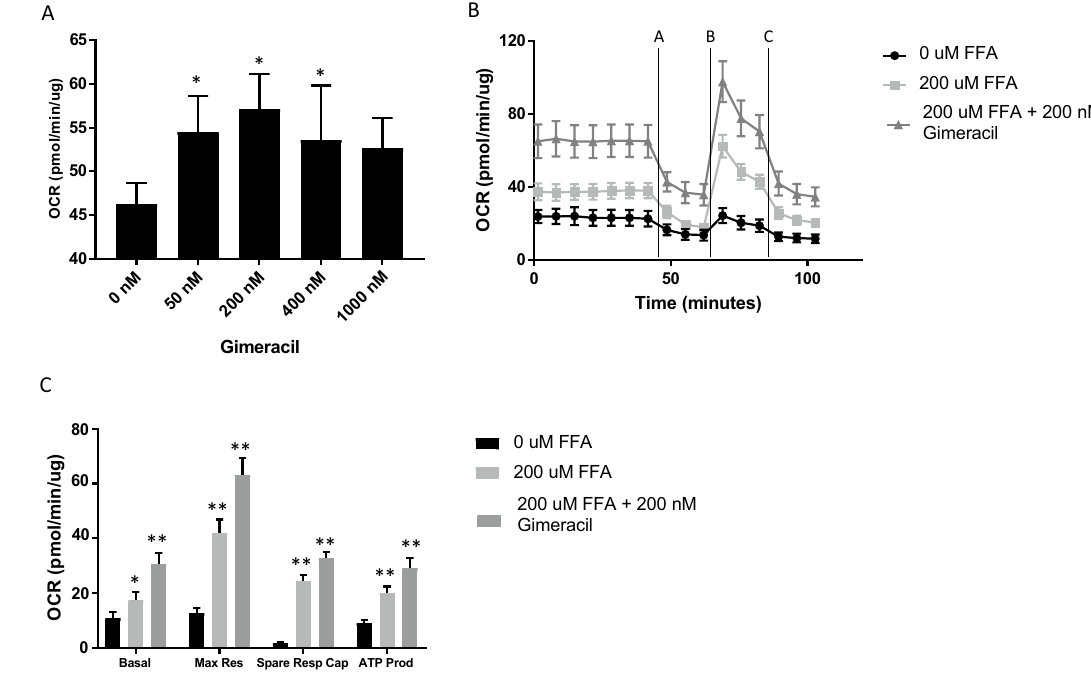
Figure 3. Extracellular flux analysis demonstrates enhanced mitochondrial functionality in PHHs treated with Gimeracil. Mitochondrial stress test involves the addition of oligomycin A (2.0 µM, time interval A) FCCP (2.0 µM, time interval B) and Rotenone Antimycin A (0.5 µM, time interval C). * indicates adjusted p-value < 0.05 and ** indicates adjusted p-value < 0.0001. ( A ) PHHs treated with increasing concentrations of the Gimeracil in the presence of 200 µM palmitic and oleic acid demonstrate a significant increase in oxygen consumption rate (OCR) at 50 nM (adjusted p-value 0.0173), 200 nM (adjusted p-value 0.0017) and 400 nM (adjusted p-value 0.0754). The increased observed at 1000 nM is not statistically significant (adjusted p-value 0.0754). ( B ) OCR normalized to total cellular protein demonstrates FFA treatment (light gray square) increased OCR and 200 nM Gimeracil (dark gray triangle) further increased OCRrelative to no treatment (black circle). ( C ) Basal oxygen consumption increased with both FFA treatment (light gray, adjusted p-value 0.0064) and FFA and Gimeracil treatment (dark gray, adjusted p-value < 0.0001). Maximal respiration, spare respiratory capacity and ATP production increased with FFA treatment (adjusted p-value < 0.0001 for all three metrics) and increased further with Gimeracil treatment (adjusted p-value < 0.0001 for all three metrics).